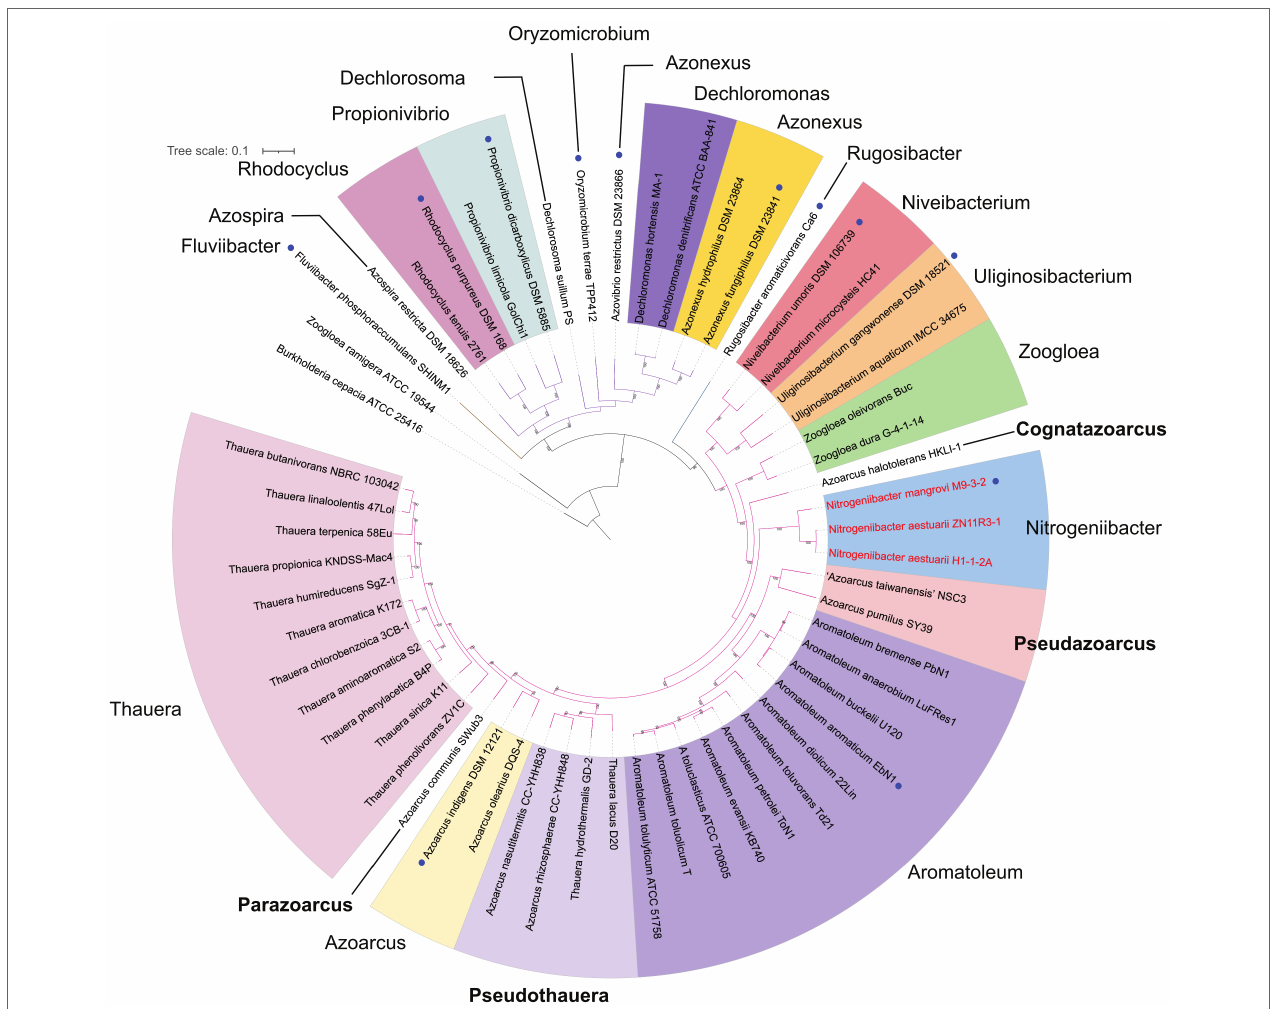
FIGURE 3 | Phylogenomic analysis of the Nitrogeniibacter members and type strains affiliated to the order Rhodocyclales based on 120 bacterial conserved single- copied gene sets of the members. The bootstrap values on the nodes are displayed by >70. Bar, 0.1 represents the nucleotide substitution per position. Blue circles represent type species. Red names show Nitrogeniibacter members. The branch color represents the families, Zoogloeaceae , Azonexaceae , and Rhodocyclaceae of the order Rhodocyclales . Four genera proposed in this study are marked